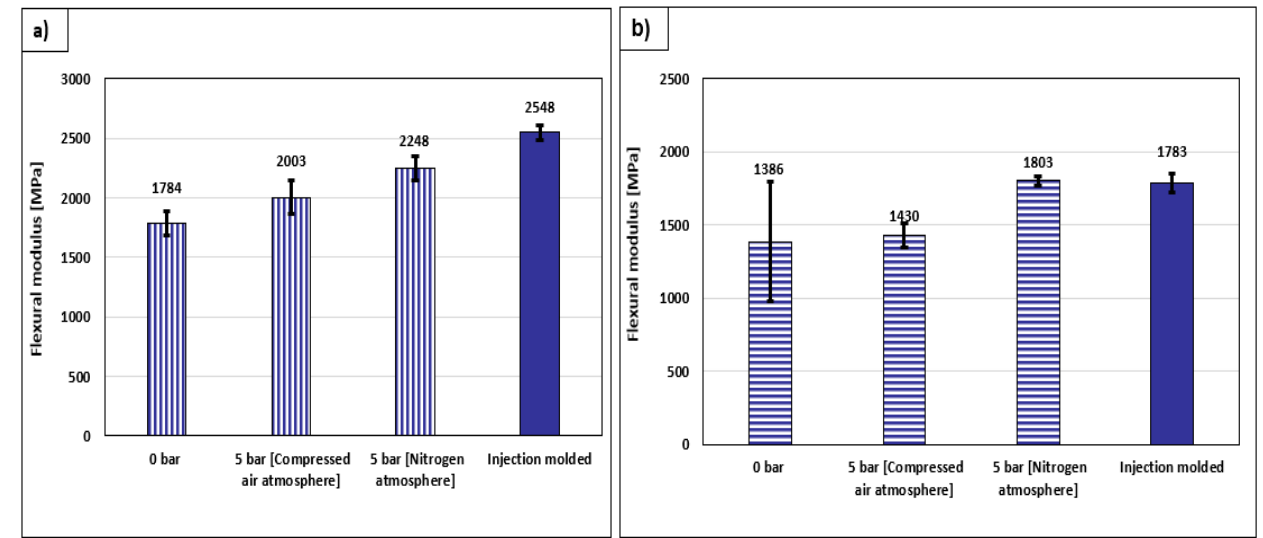
Figure 6. Comparison of materials ’ flexural modulus printed under various pressure levels longitudinally ( a ) and transversely ( b ) to the printing direction.